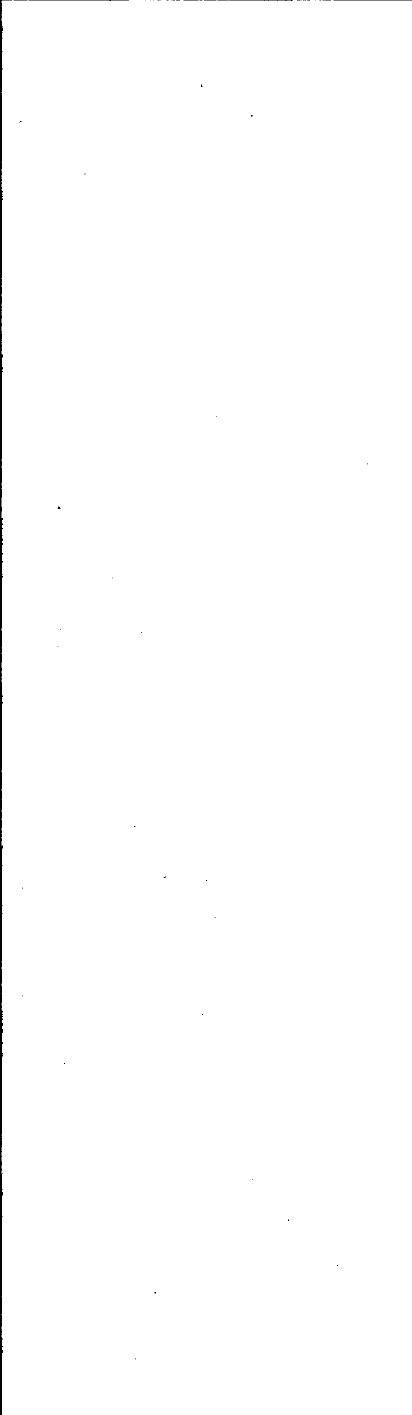
Figure I: Student response to the question of how useful online resources would